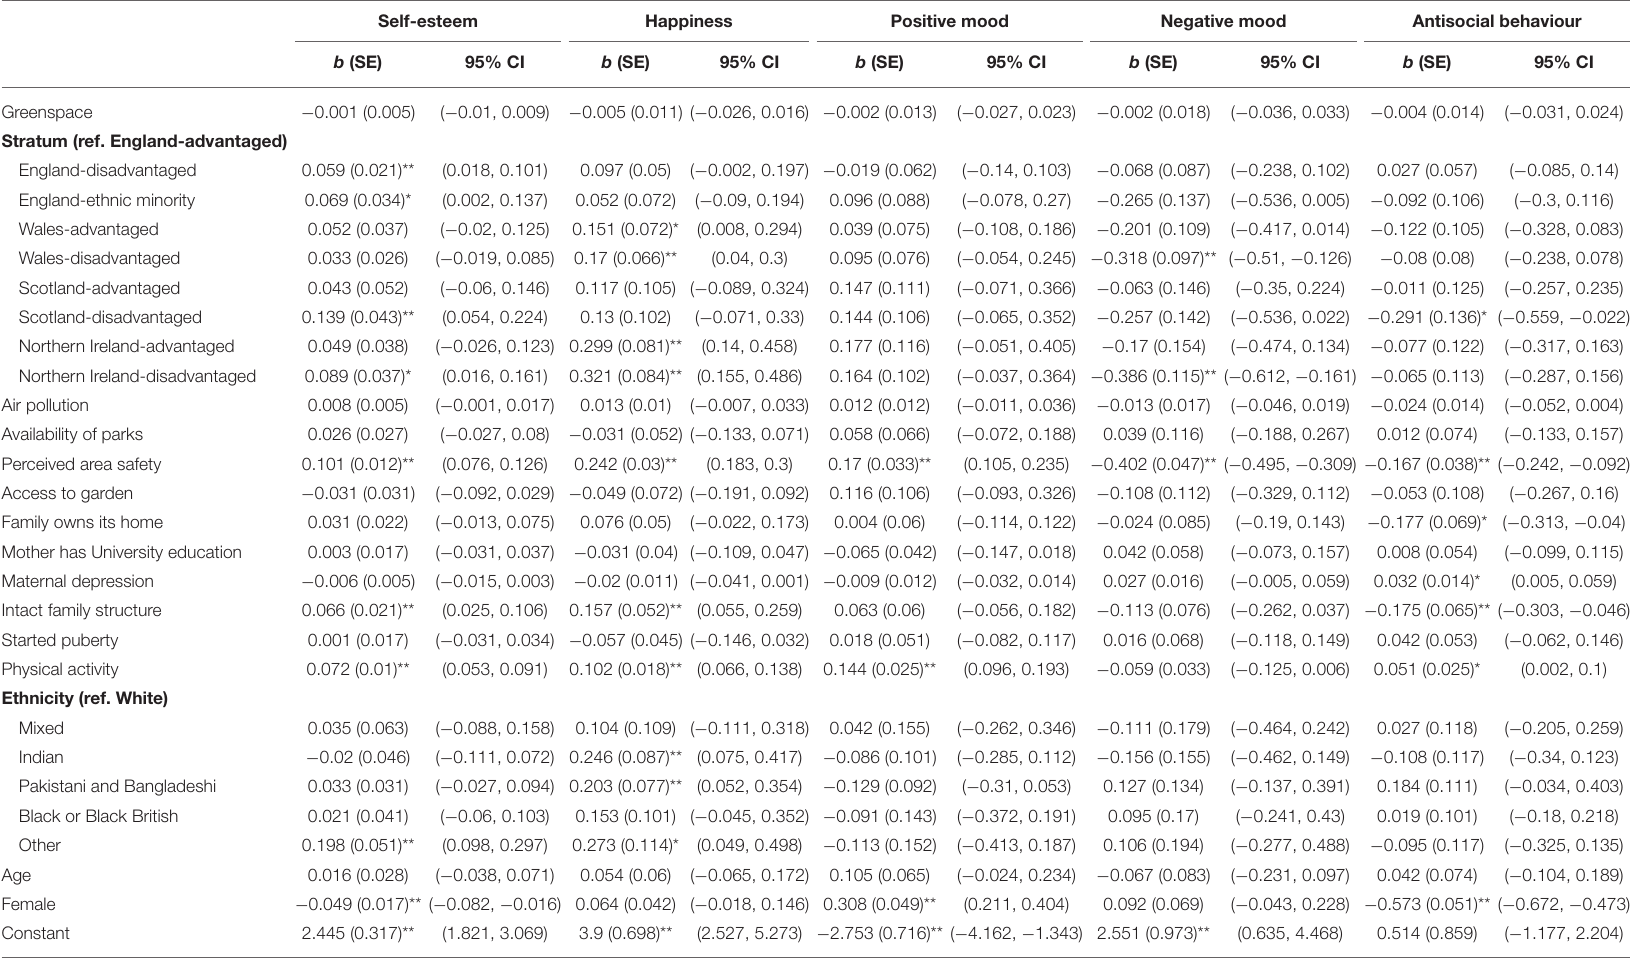
TABLE 3 | Fully adjusted regression models predicting self-esteem, happiness, positive mood, negative mood, and antisocial behaviour ( n =